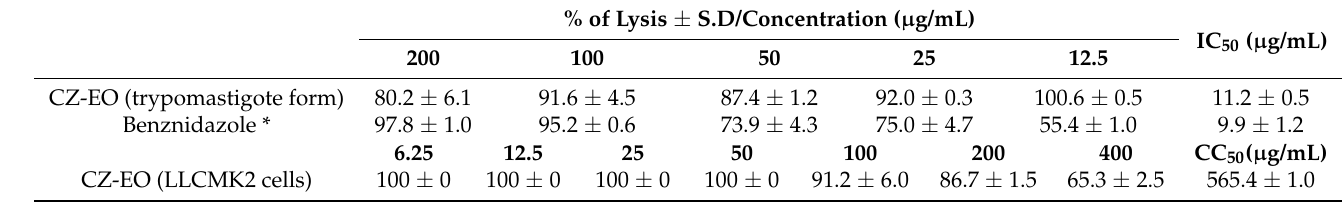
Table 4. In vitro trypanocidal of CZ-EO against the Trypanosoma cruzi trypomastigote form and its cytotoxicity to LLCMK 2